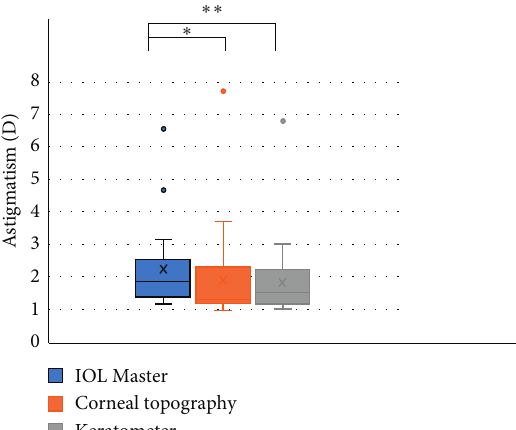
Figure 5: Corneal astigmatism measured by 3 devices preoperatively. The value measured by IOL Master is higher than those by the corneal topography ( ∗ p < 0 . 05) and using a keratometer ( ∗∗ p < 0 . 005).